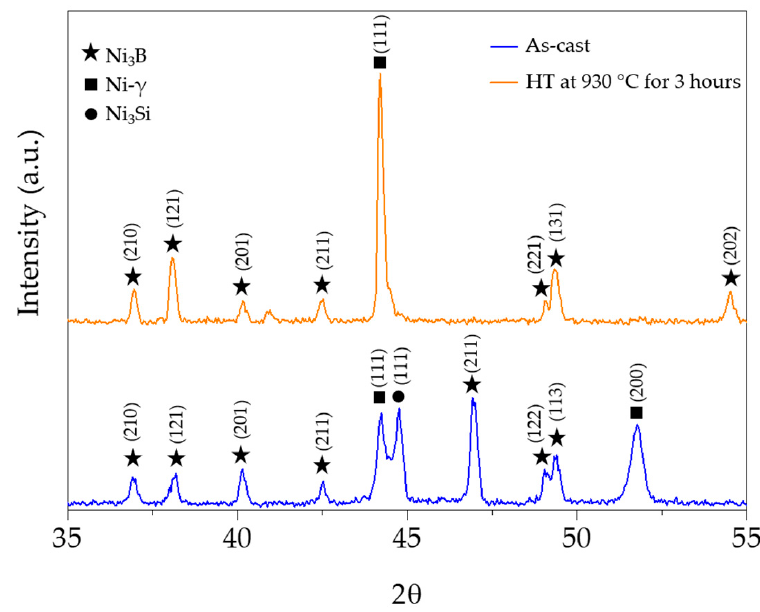
Figure 5. XRD patterns of the as-cast and heat-treated NiSi3B2 specimens.